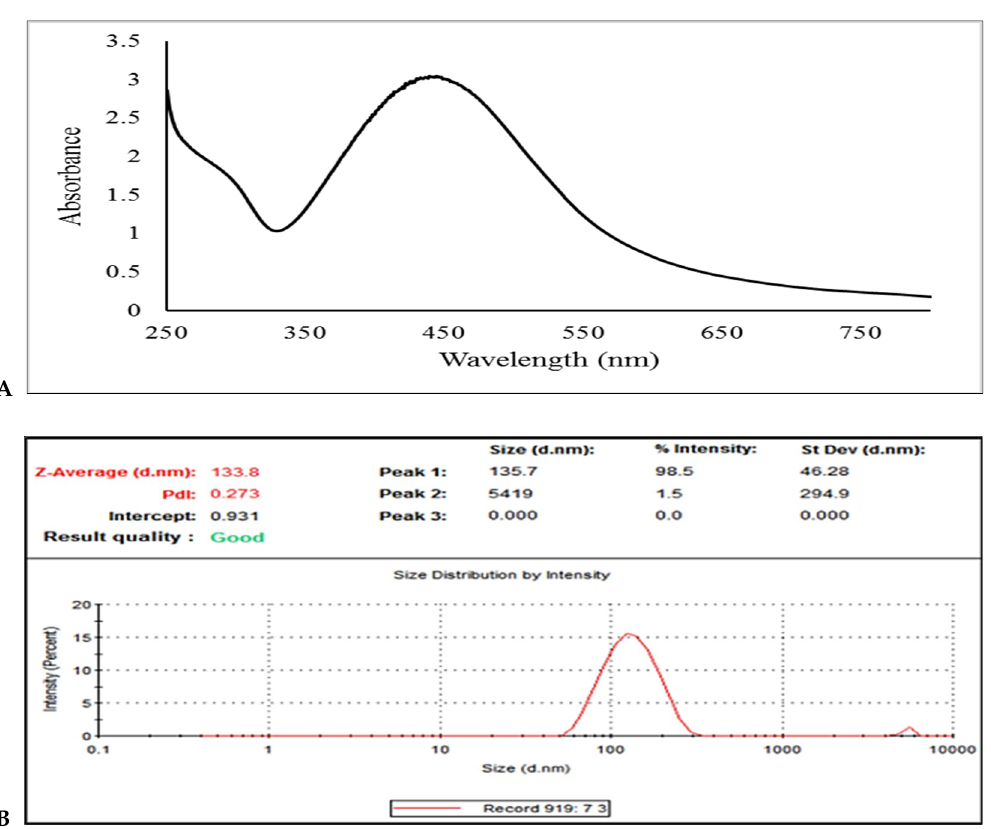
Figure 1. ( A ) The absorption spectrum of the green silver nanoparticles synthesized with G. mangostana and ( B ) a graph of a Zetasizer measurement of the average size of green Ag-NPs.